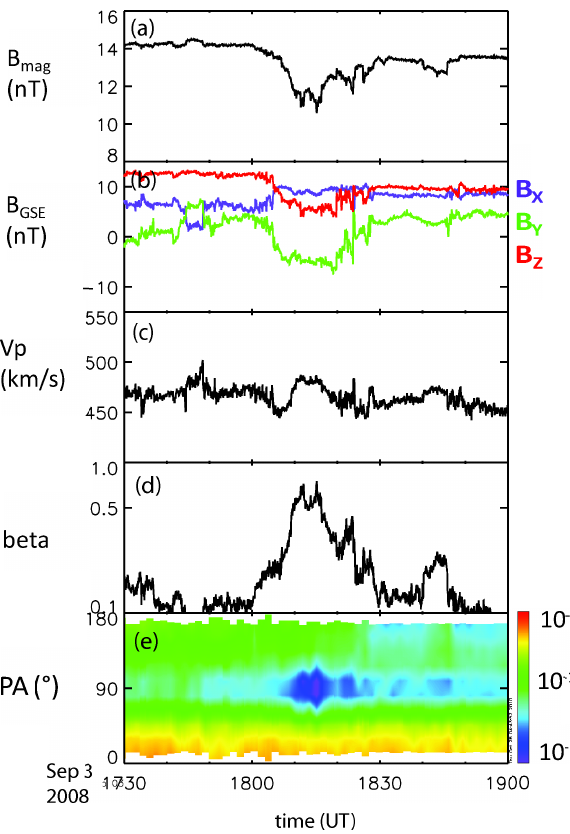
Fig. 2. Zoom-in around the 90 ◦ pitch angle depletion (arrow in Fig. 1). The panels give from top to bottom (a) magnetic field mag- nitude, (b) magnetic field components in GSE, (c) solar wind speed, (d) plasma beta, and (e) the electron pitch angle spectrograms for the low-energy Electron Electrostatic Analyzer (EESA-L) on the 3DP instrument of Wind energy channel 249eV. The color cod- ing indicates the amplitude of the distribution functions in units of s 3 km − 3 cm − 3 .